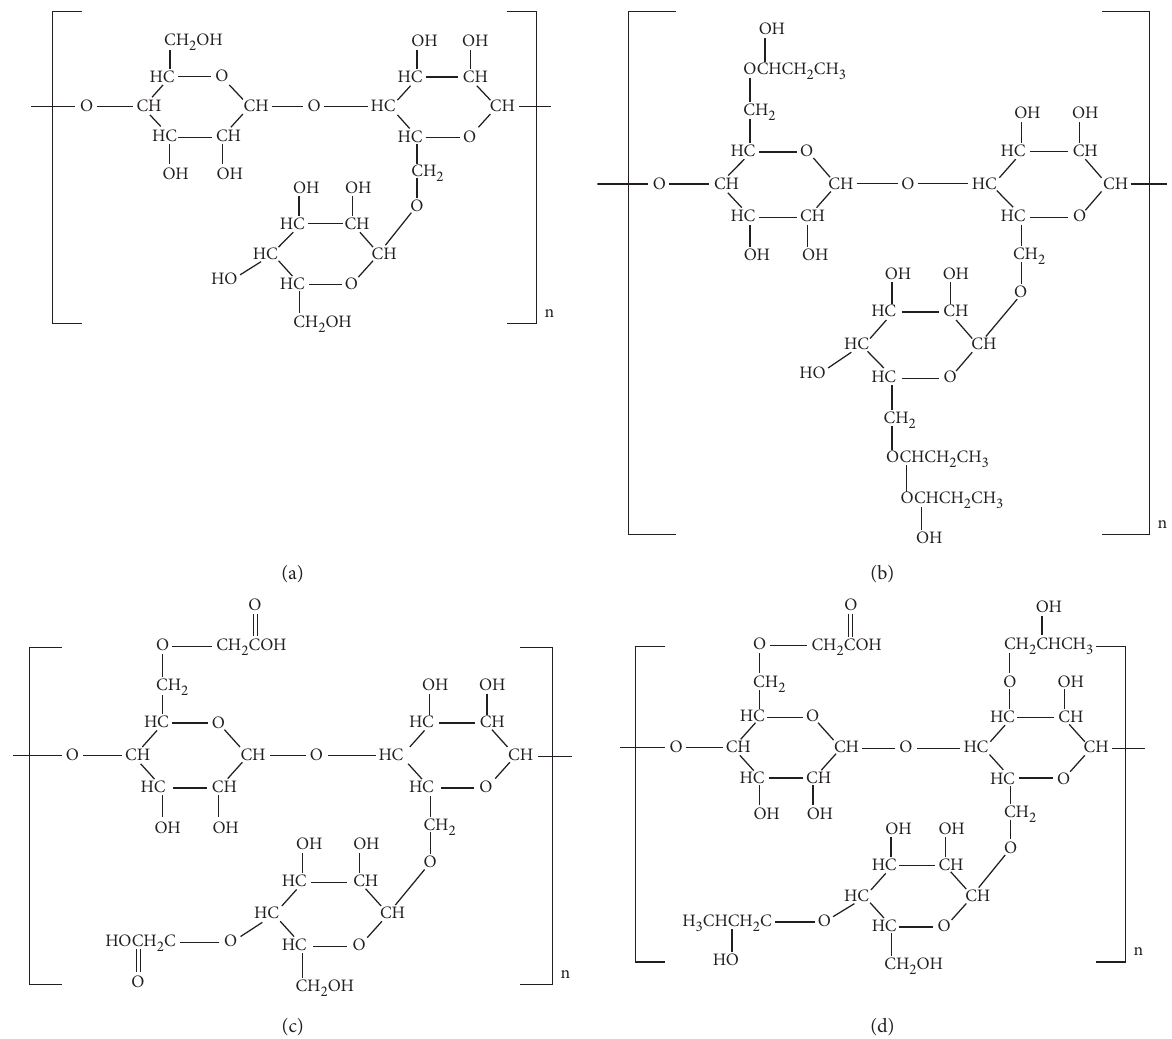
Figure 1: The molecular structure of (a) guar gum, (b) HPG, (c) CMG, and (d) CMHPG.